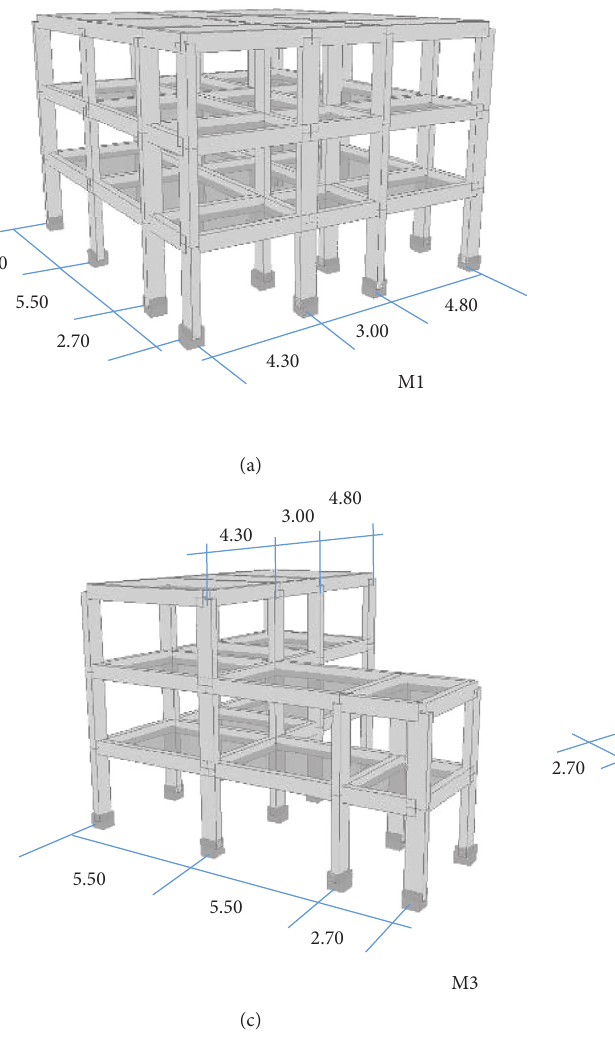
Figure 3: Reference numerical models (axonometric view obtained by the software).